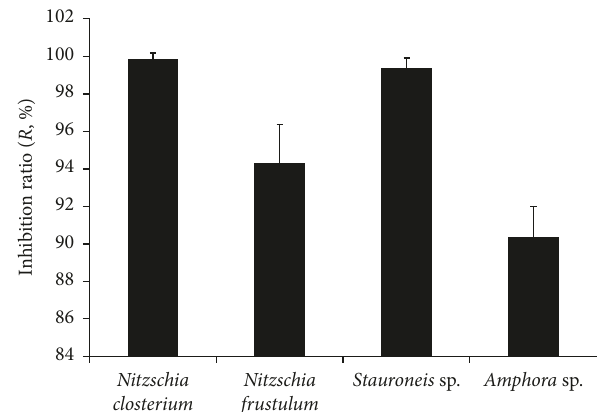
Figure 3: Activities against diatom biofilm formation by the crude extract from the whole culture of Psychrobacter sp. The inhibiting ratios ( R ) were calculated after 24h incubations. Triplicates were tested for each treatment and control, and the means and standard deviations are shown as closed columns and bars, respectively.